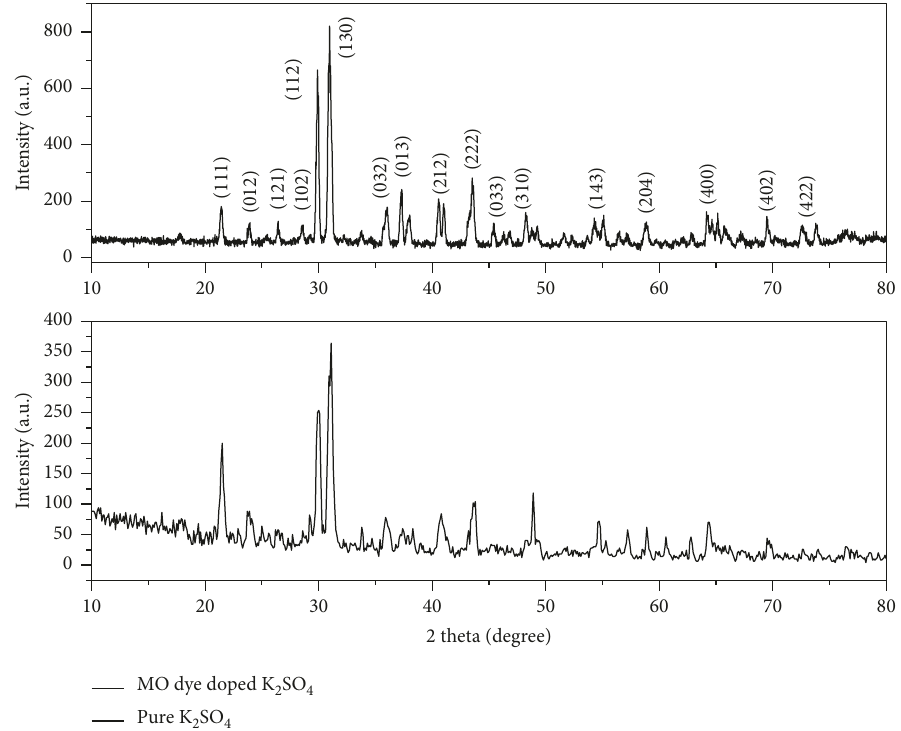
Figure 1: X-ray diffraction pattern of pure and methyl orange doped K